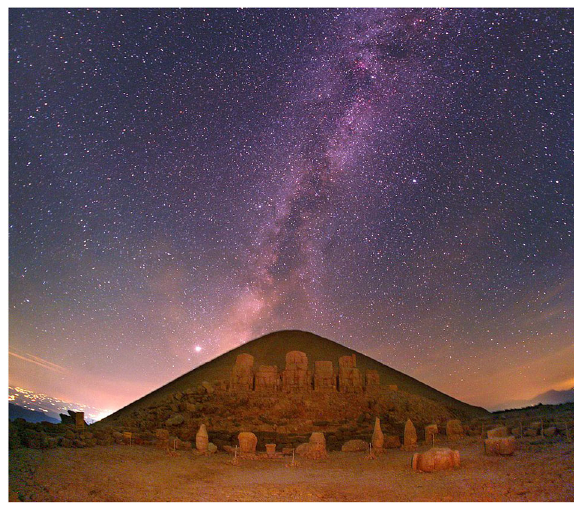
Fig. 1 The main sanctuary of Commagene on top of Mt. Nemrud. View from the East terrace at dawn, the Milky Way above the tumulus and Jupiter to the left of the statues. Photo by Tunç Tezel. This fi gure is not covered by the Creative Commons Attribution 4.0 International